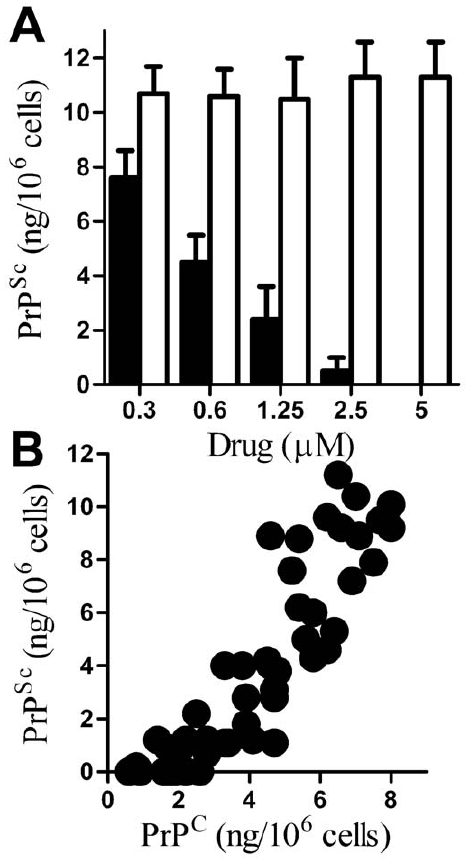
Figure 5. Glimepiride reduced the PrP Sc content of ScGT1 cells. (A) The amount of PrP Sc in ScGT1 cells treated for 7 days with different concentrations of glimepiride ( & ) or with glibenclamide ( % ). Values shown are the mean average amount of PrP Sc (ng/10 6 cells) 6 SD, n=12. (B) Correlation between the amount of PrP C at the surface of ScGT1 cells after 1 hour incubation with different concentrations of glimepiride and the amount of PrP Sc in ScGT1 cells following treatment for 7 days.